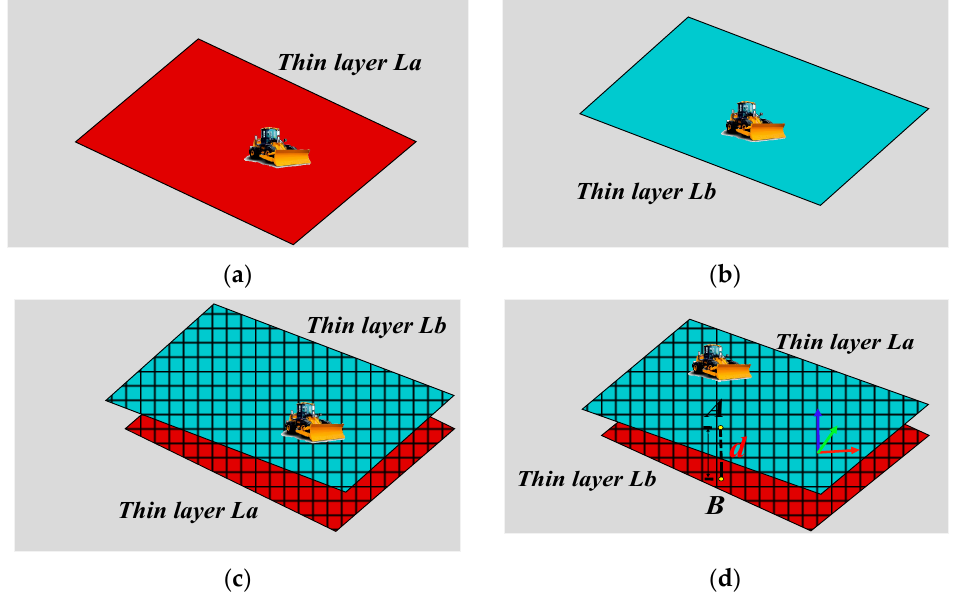
Figure 6. Calculation process of paving thickness of storehouse surface: ( a ) elevation of the previous storehouse; ( b ) elevation of storehouse in construction; ( c ) superimposition of ( a , b ); ( d ) calculation of paving thickness of storehouse surface.